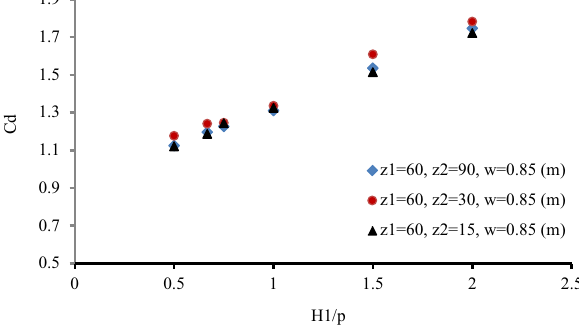
Fig. 8 Discharge coefficients for z heights